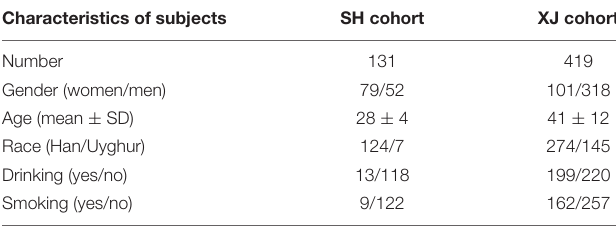
TABLE 1 | Characteristics of healthy